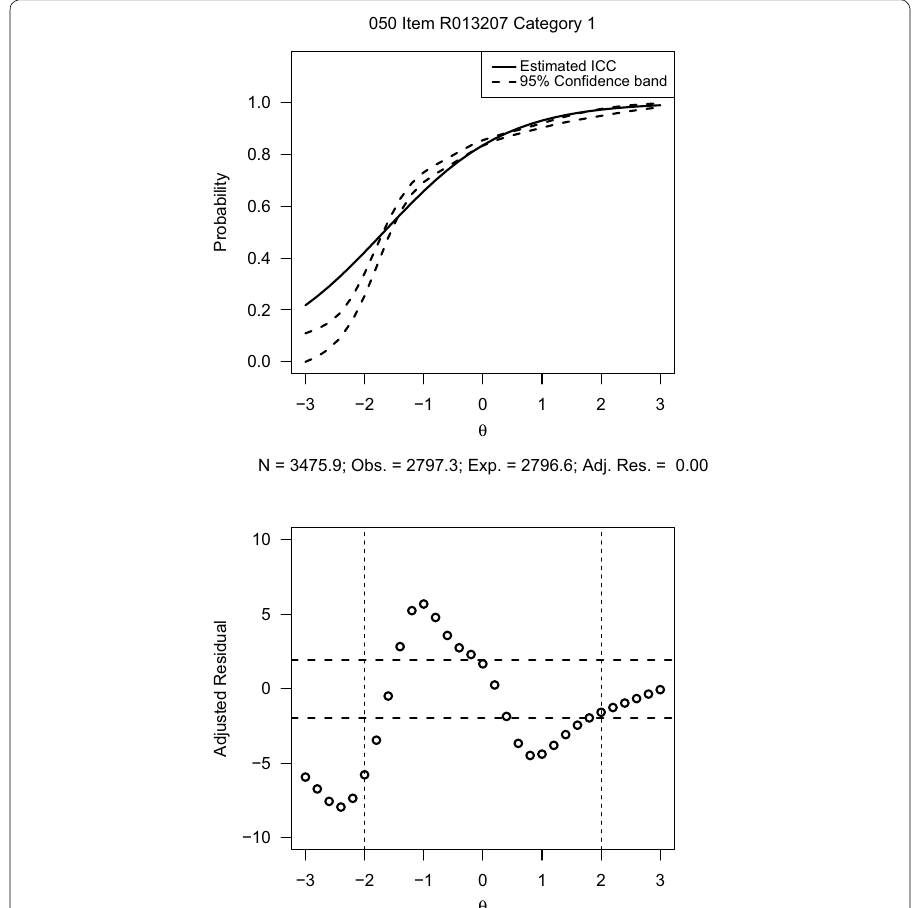
Fig. 4 Item-fit plots and residuals for a 2005 reading grade 12